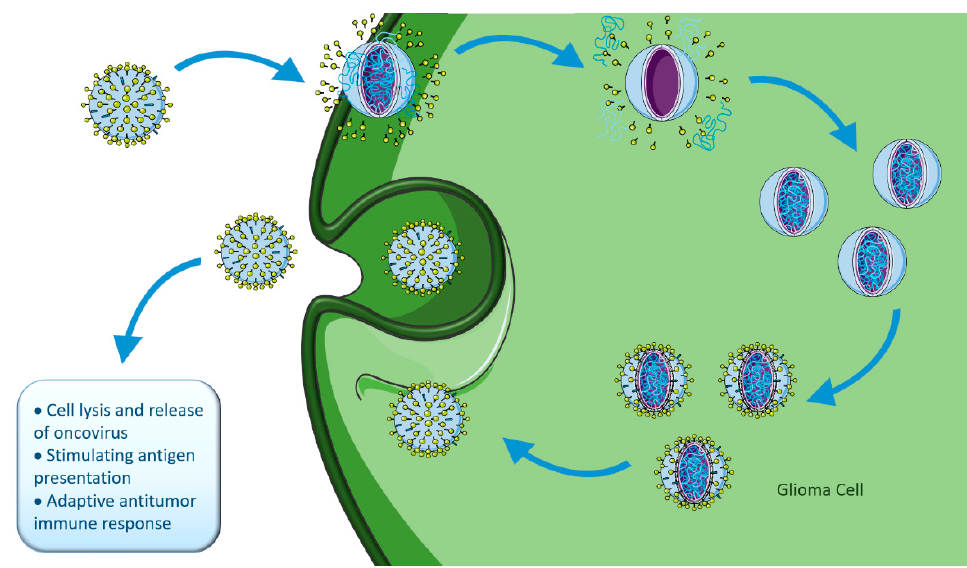
Figure 8. Oncolytic viral therapy. Figure drawn with